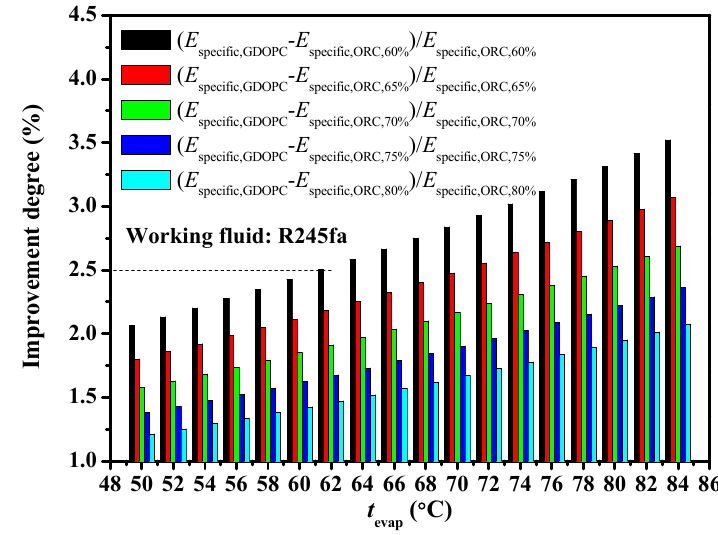
Figure 5. The improvement degree of specific energy.